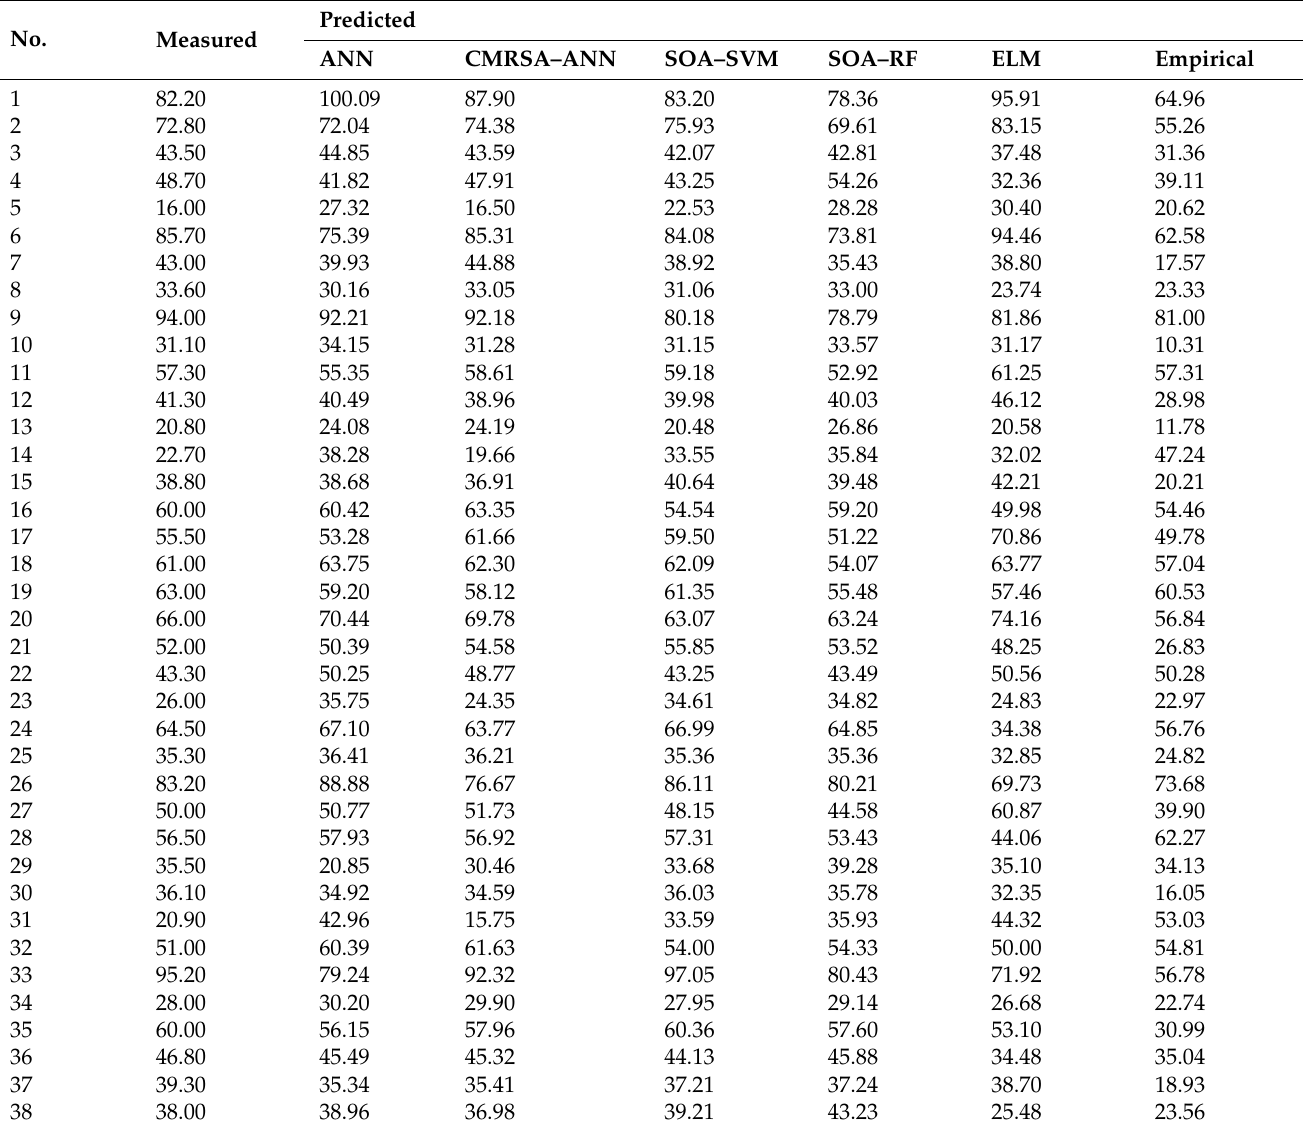
Table 6. Prediction results of the compressive strength of RHA concrete using the developed